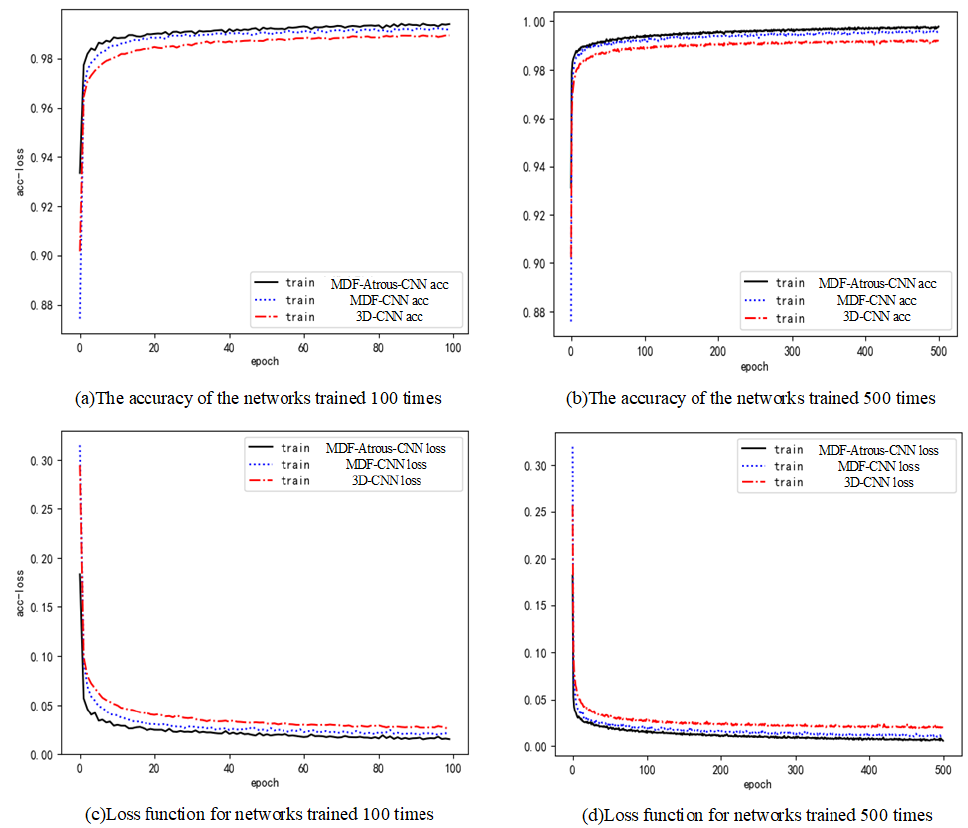
Figure 8. Loss function and accuracy of three network model training. Table 3. Training results of three network